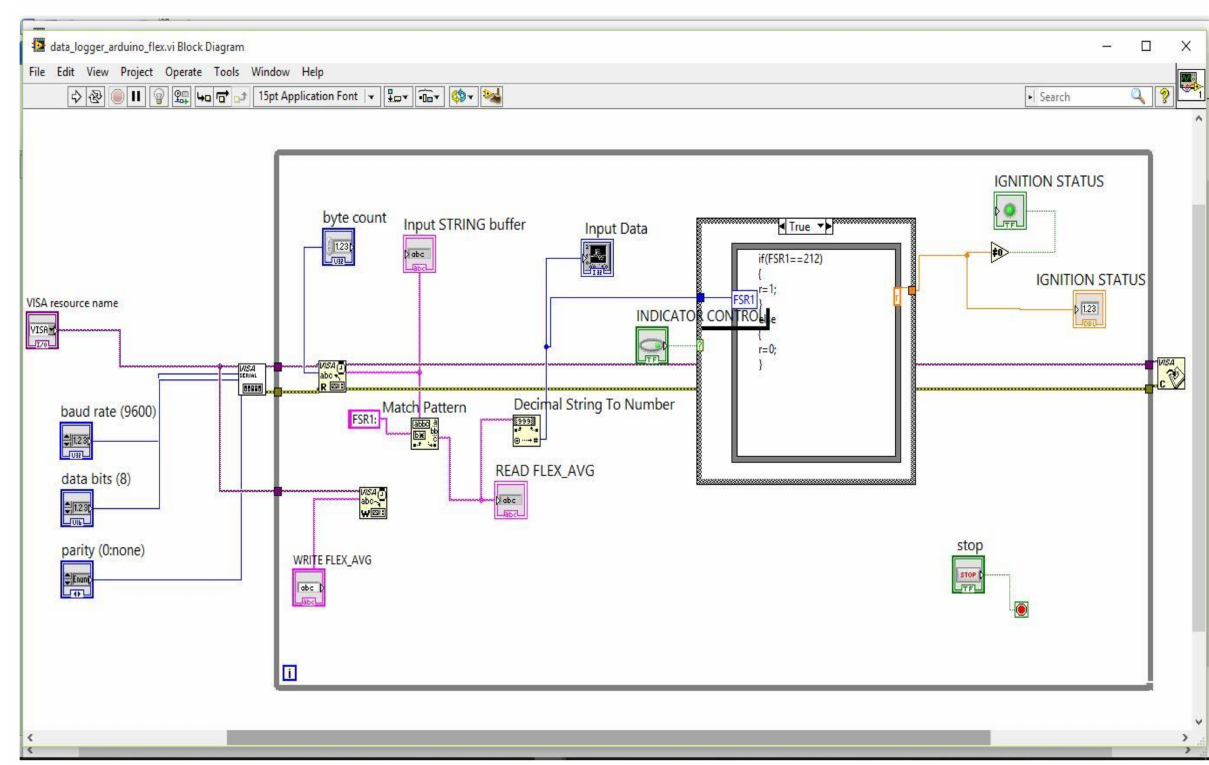
Figure 16. Block diagram for Lab VIEW for the system analysis.